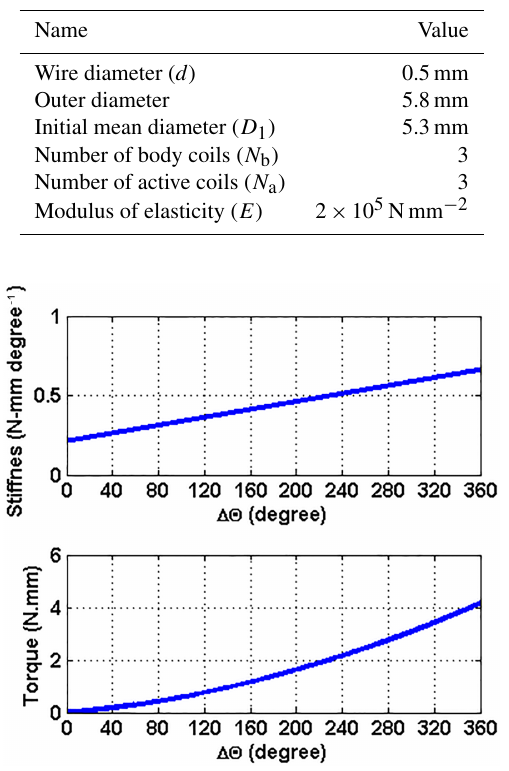
Figure 2. Supplied torque by VSA corresponding to the change of stiffness with respecting to the deflection.